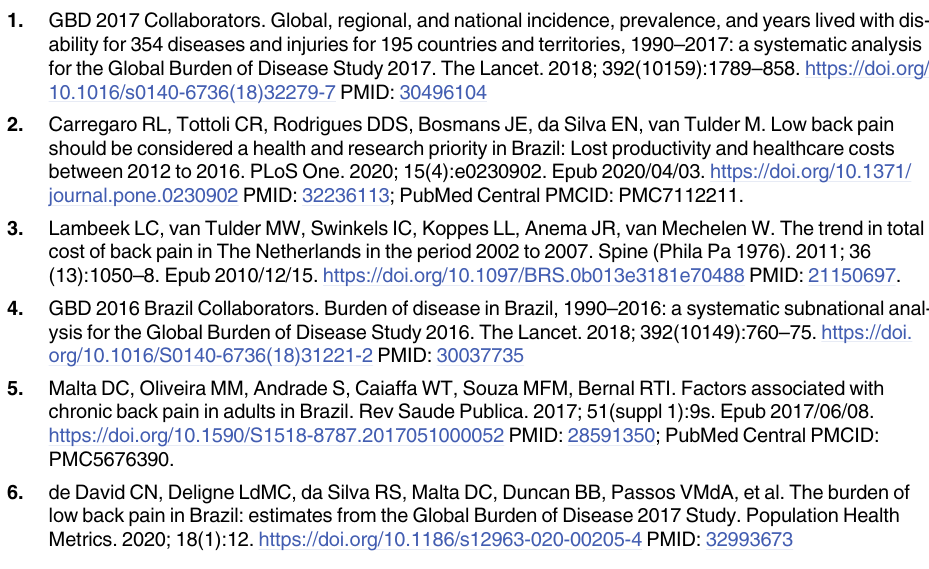
S1 Table. Adjusted odds-ratios and 95% confidence intervals on the associations between getting types of treatment for pain and biopsychosocial variables. � p < 0.05, �� p < 0.01, ��� p <